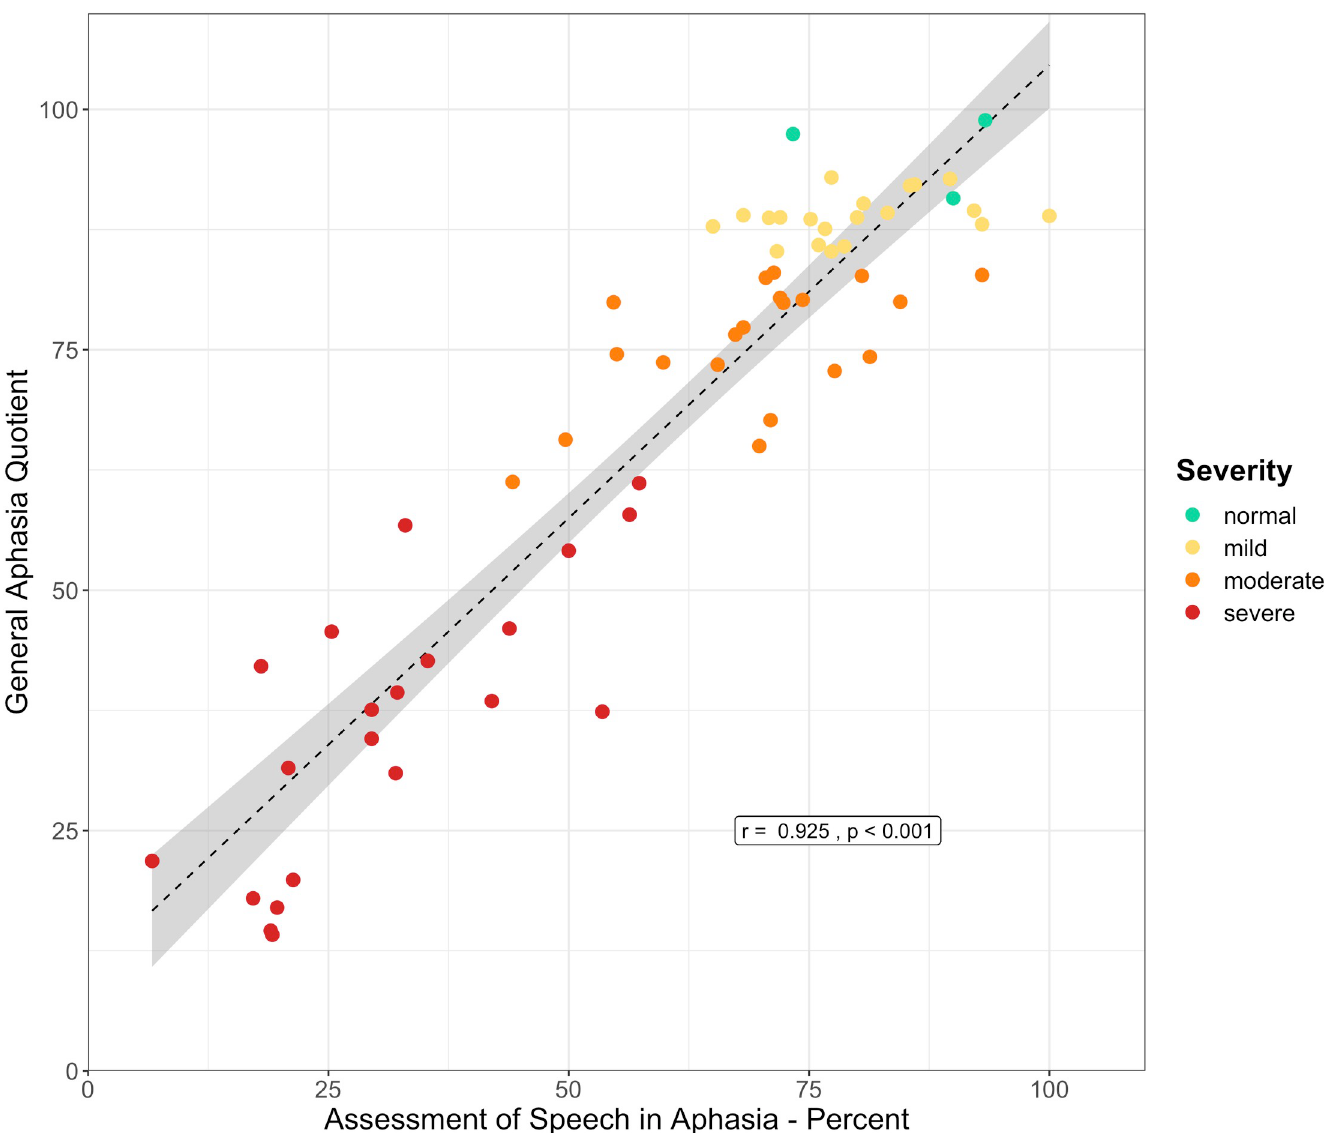
Fig 4. Correlation between the General Aphasia Quotient (GAQ) of the RAT and the total score on the Assessment of Speech in Aphasia (ASA), a widely used aphasia battery in Russian. Different colors indicate different severity ranks based on the GAQ.